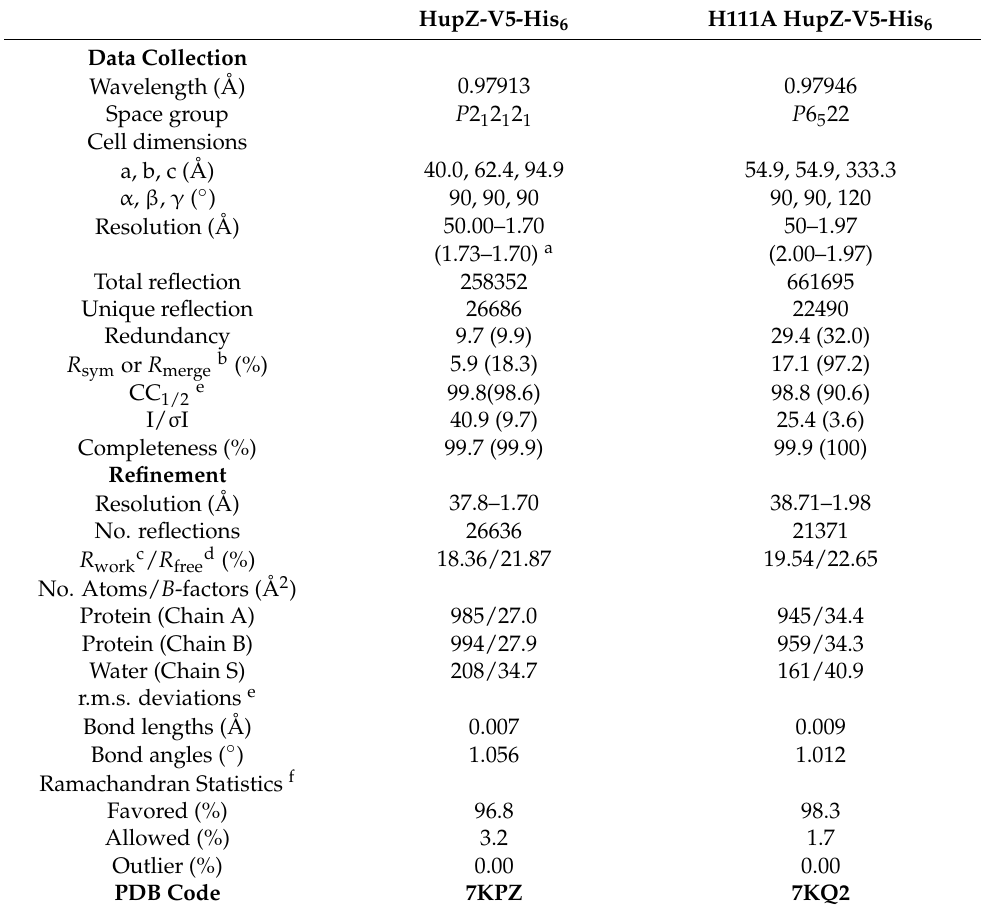
Table 2. X-ray diffraction data collection and refinement